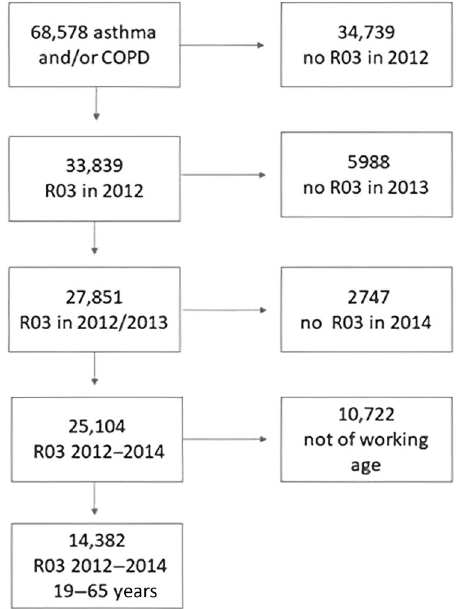
Fig. 1 Flowchart 2012 MAJORICA database. Patients with asthma and/or COPD diagnosis on active ATC code R03 treatment and of workingage (19 – 65